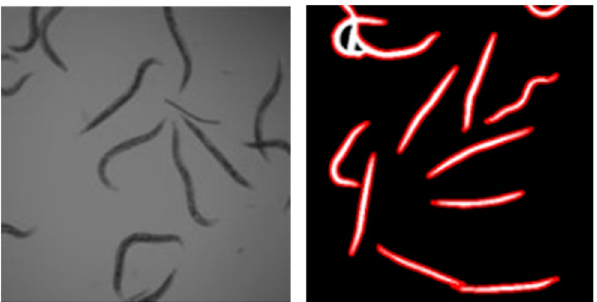
Fig 6. Example pair programming project in which students aimed to count the dead (straight) worms in a series of images. The unprocessed image is from [56].